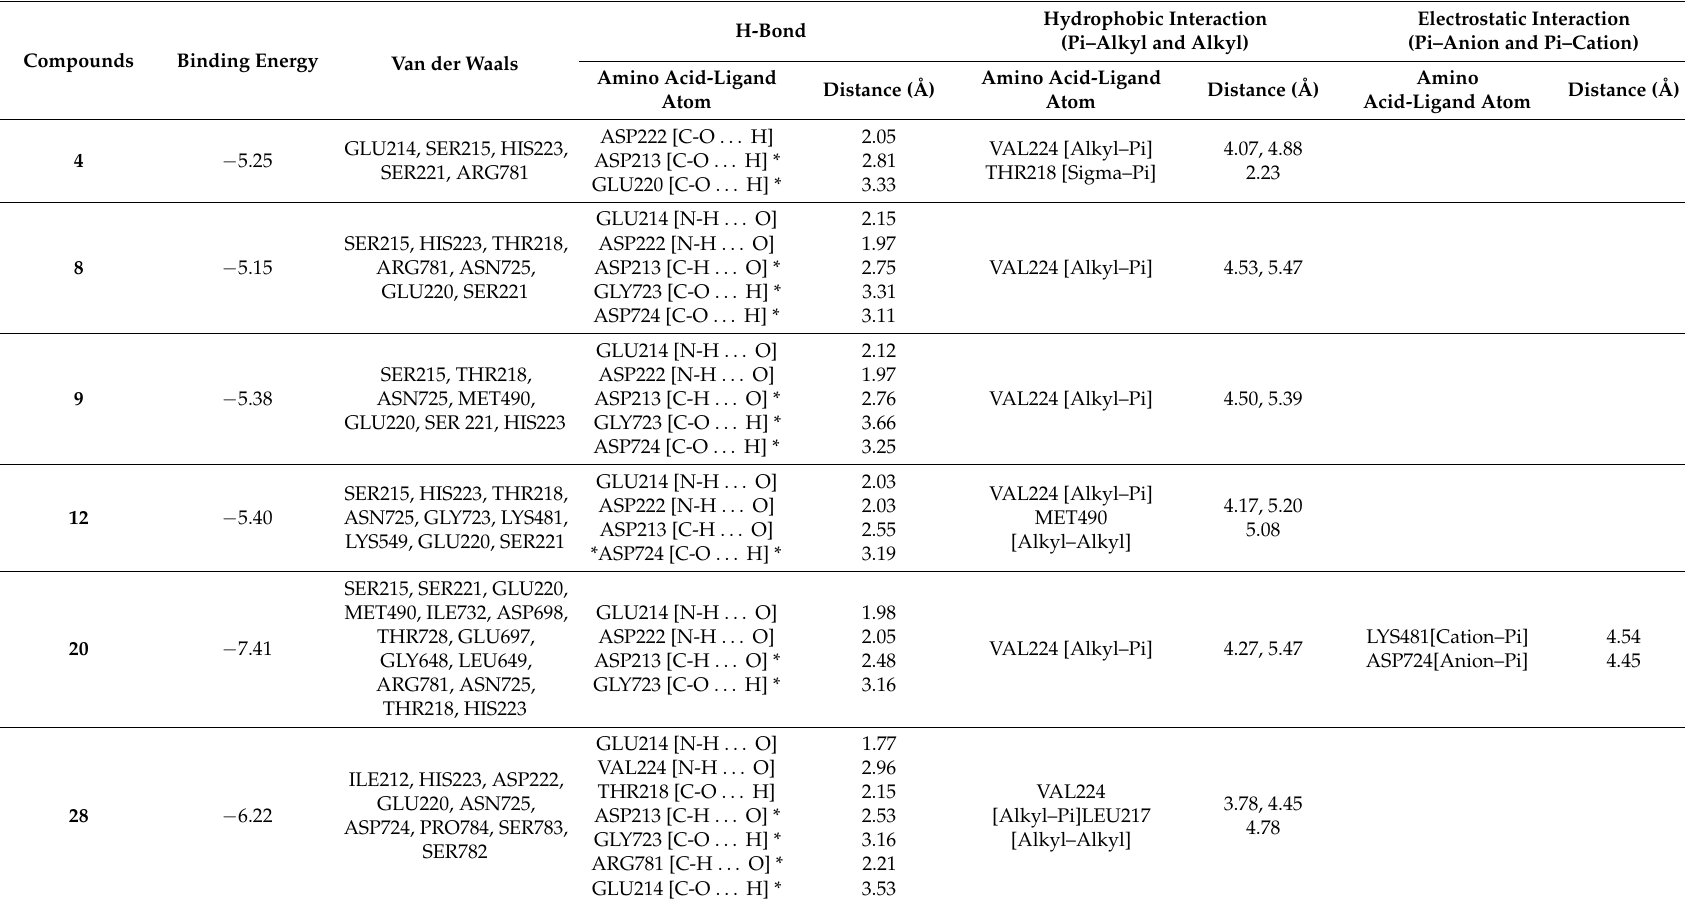
Table 8. Binding energy and nonbonding interaction of scopoletin and its